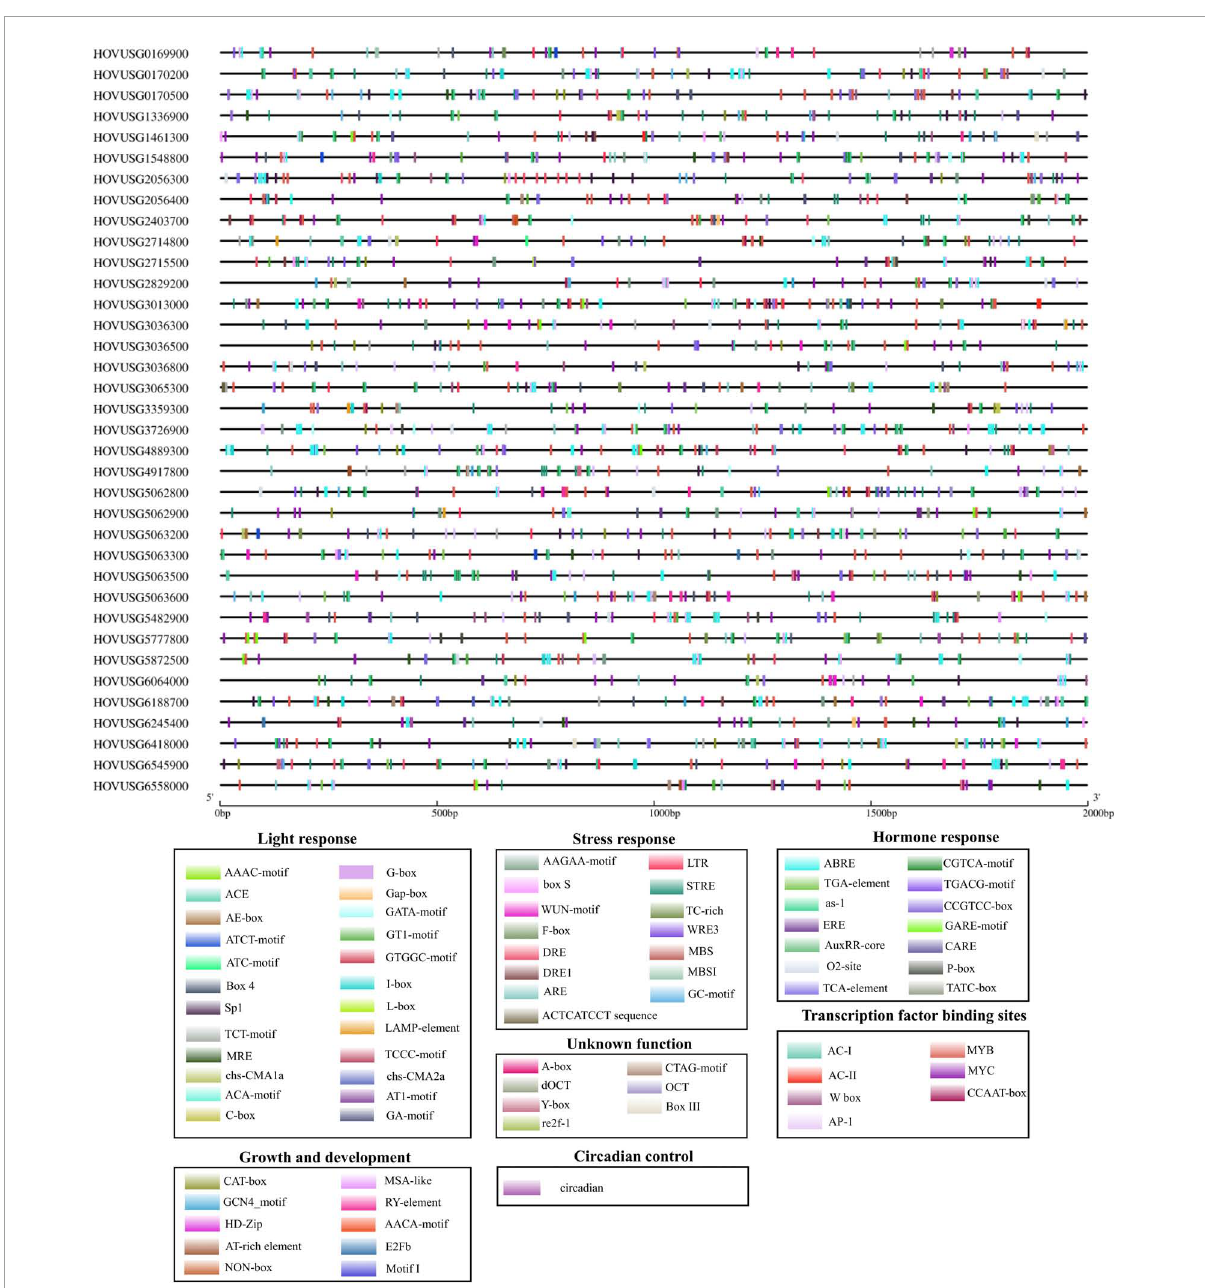
FIGURE5 Distribution of cis -elements in the promoters of Qingke TLP genes. Black lines indicate the promoters. Cis -elements differing in function are color-coded